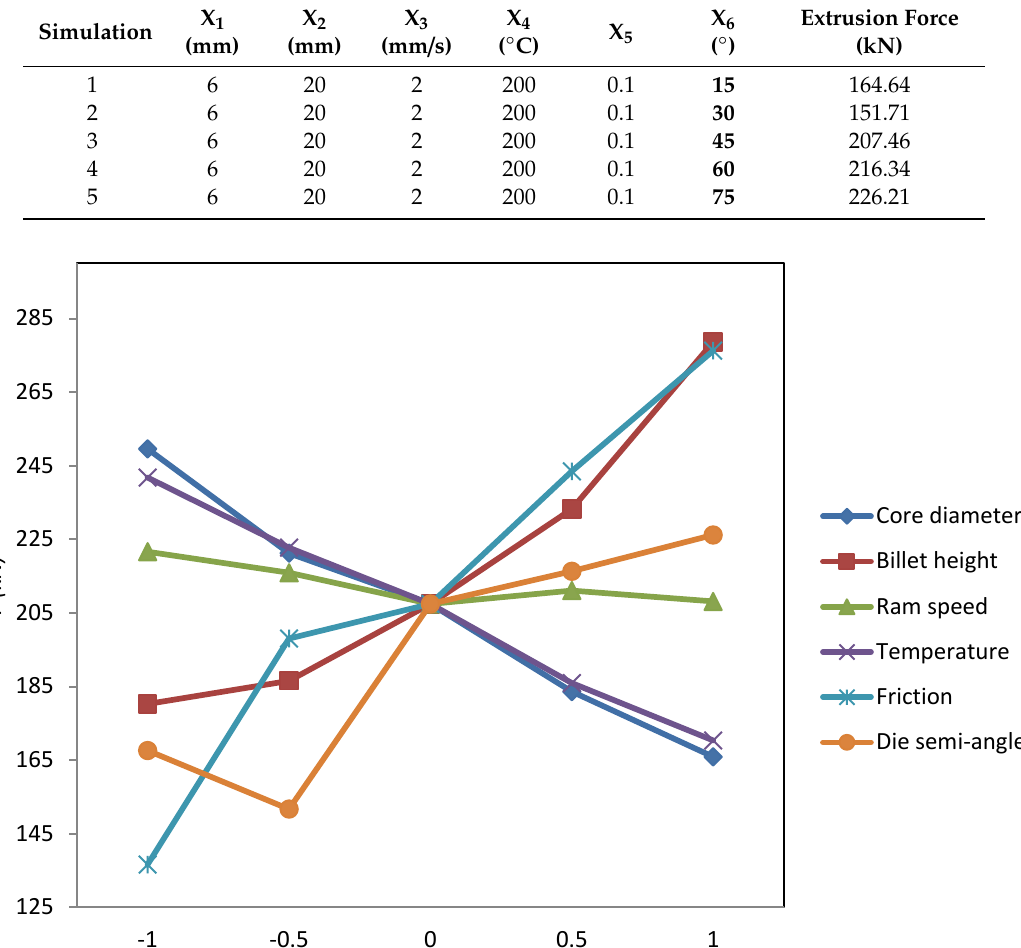
Table 11. Variables combination by varying X 6 (die semi-angle).